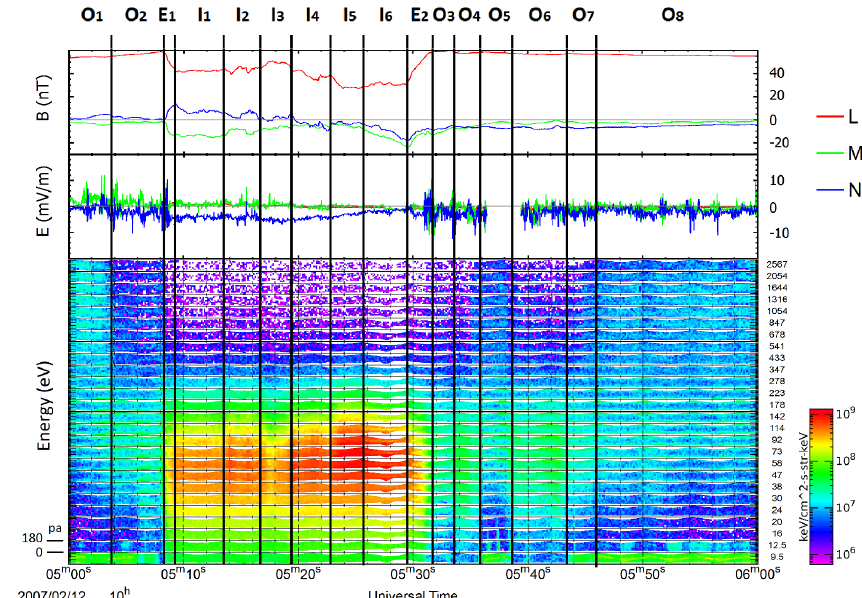
Figure 5. High-time-resolution observations by Cluster 1 from 10:05UT to 10:06UT: the top two panels represent magnetic field from FGM instrument and electric field from EFW instrument plotted in the LMN coordinate system, respectively in red, green and blue colour. A horizontal grey line highlights the zero value for each of them. The bottom panel is a “Sauvaud” differential energy flux plot for electron pitch angle distributions from PEACE LEEA instrument, covering energies from 9.5eV to 2.5keV. The vertical black lines separate different identified regions of the FTE, with their relevant labels on the top. The regions include outer layers marked as “O”, edges marked as “E” and inner layers marked as “I”. O 1 and O 8 are the outermost layers of draped magnetic field lines where energetic electrons were observed; O 2 , O 3 , O 5 and O 7 are inside the boundary layer, with energetic electrons being replaced by bidirectional electrons of ∼ 100eV, and an active electric field; O 4 and O 6 are still inside the boundary layer, consisting of isotropically distributed electrons with energies ∼ 58eV. E 1 is a thin layer of plasma at the edge of the flux tube, where the B L component reduced from its magnetospheric value, the B N component reached its bipolar maximum, the electric field level reached its maximum level and a higher flux of electrons with average energy of ∼ 58eV developed from the bidirectional electrons of boundary layer. The core labelled as “I” is divided into six layers, where the B N component gradually reached its minimum, the electric field stayed relatively quiet and a general heating up signature is observed in the energy distribution of electrons. Within the inner layer I 3 , the B L component reached its enhanced level, and a cold low flux population of electrons was observed. I 5 had the highest temperature within the core, and inside I 6 the electron pitch angle distribution temporarily turned more bidirectional. E 2 is the exit edge of FTE. (See Sect. 4.4.2 for